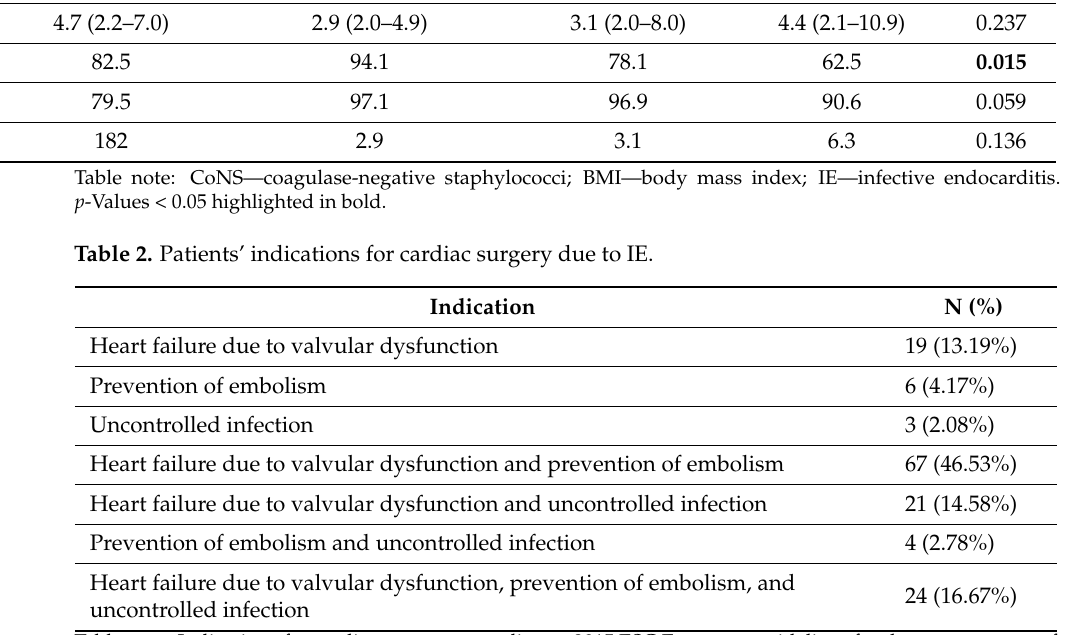
Table note: Indications for cardiac surgery according to 2015 ESC European guidelines for the management of infective